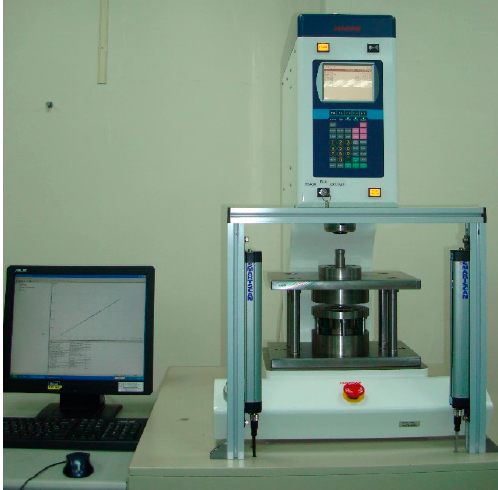
Figure 3. The micro-electronic press.